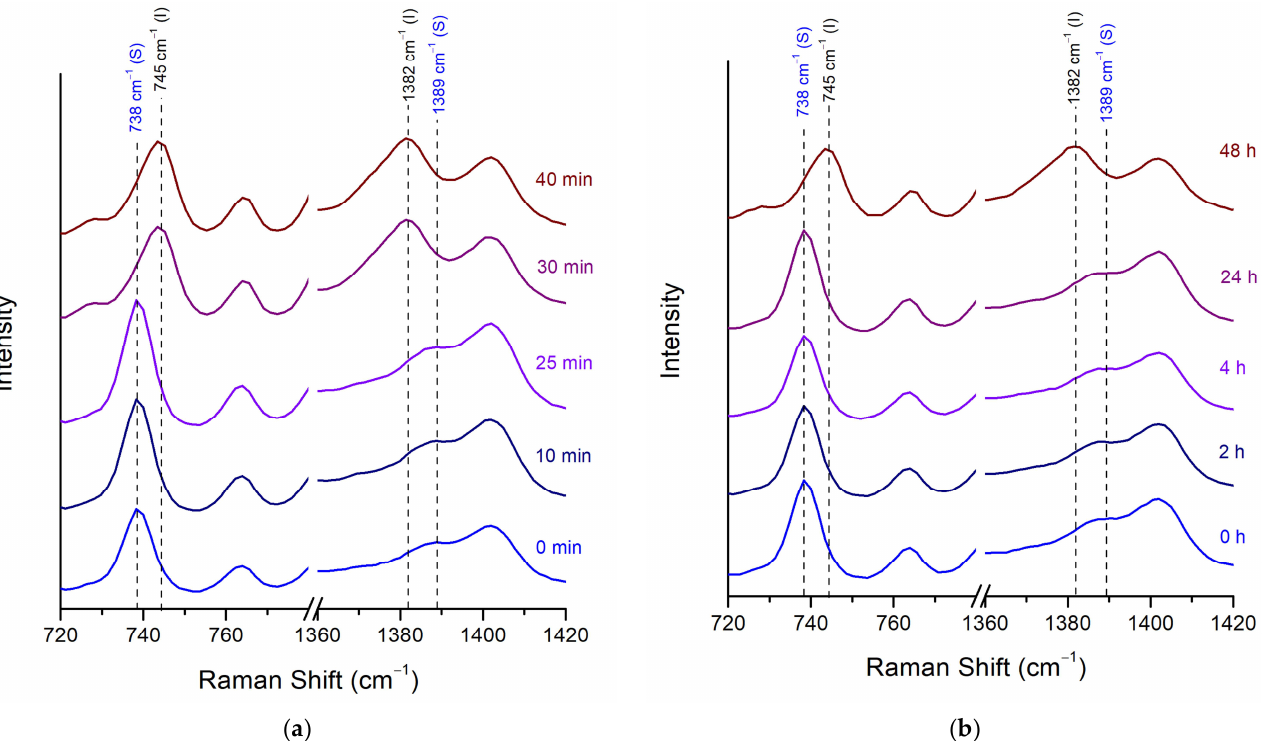
Figure 5. Raman spectra of posaconazole Form-S left in ambient conditions ( a ) without using a cover; ( b ) using LDPE cling film as a cover (black peak labels: characteristic peaks for posaconazole Form I; blue peak labels: characteristic peaks for posaconazole Form-S). Spectral areas: 720–780 cm −1 and 1360–1420 cm −1.